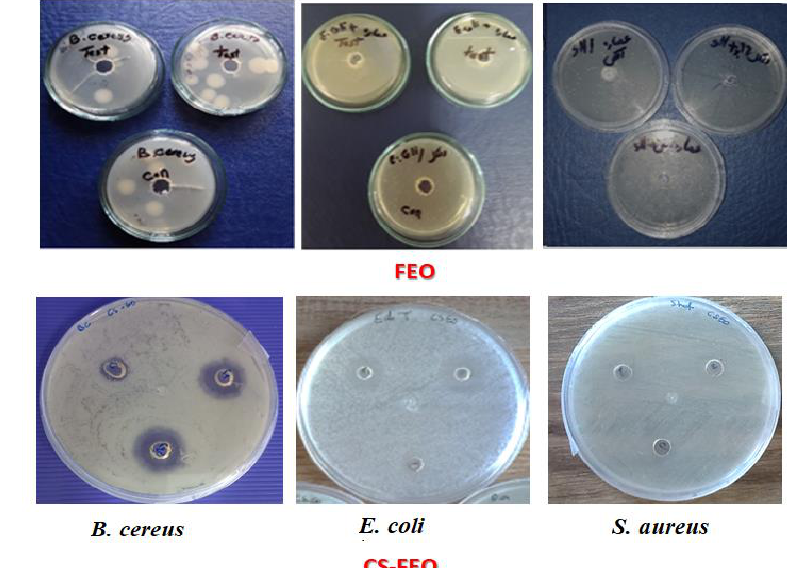
Fig. 5. Antibacterial activity of the prepared nanocomposite using agar well diffusion assay method.